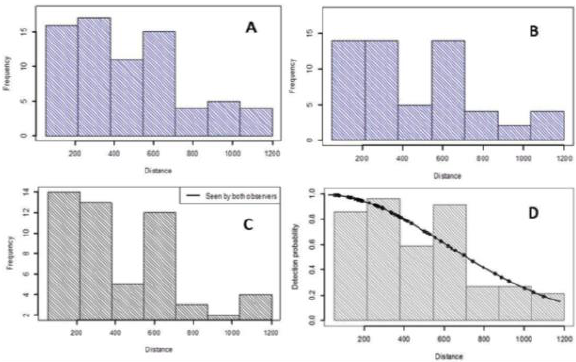
Figure 8. Scaled histograms of perpendicular distances and the predicted detection probability functions for humpback whale groups. A) Front observers, B) rear observers, C) both observers and D) pooled detections with sightings fitted to a half-normal model where each observation prediction is shown as a circle. Distance is measured in meters from the line directly below the aircraft. The data were left truncated at 50 m due to low number of detections close to the trackline.